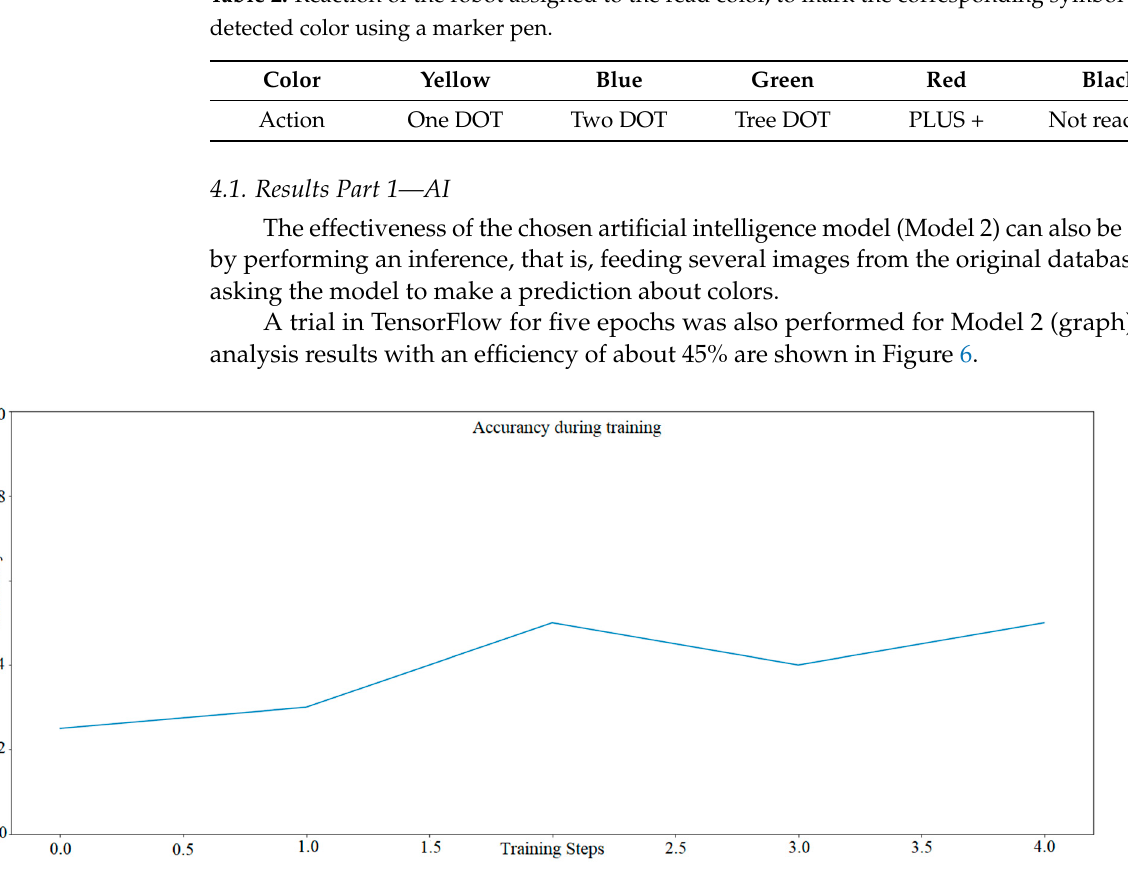
Figure 6. The learning progress of AI model with several solutions proposed by Siemens—Model two AI only 5 epochs. The graph was developed based on TensorFlow library.